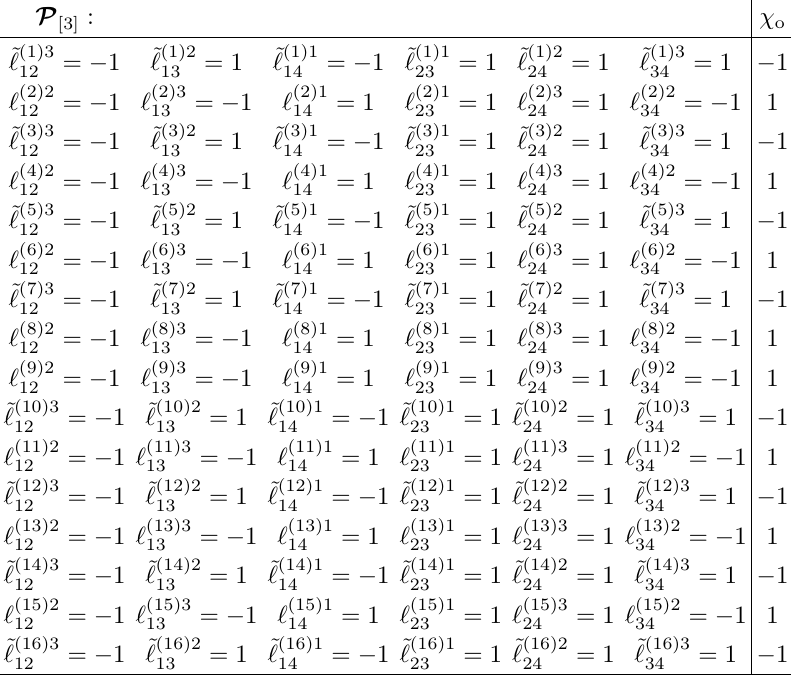
Table 13 . Non-vanishing ‘ , e ‘ , and (cid:31) o values for representation P